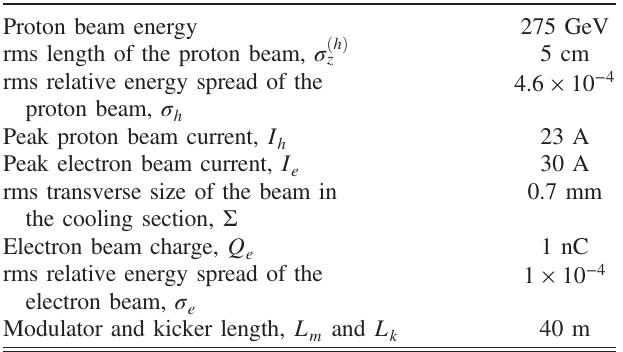
TABLE I. Parameters of the eRHIC collider with a hypothetical MBEC cooling section. Proton beam energy 275